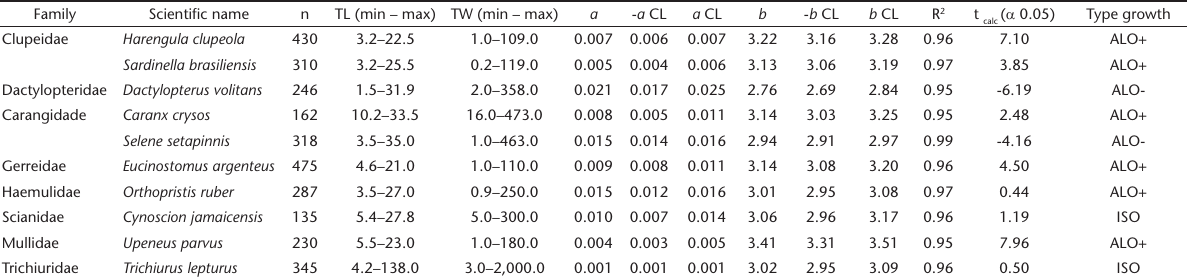
Table 1. Sample size (n), ranges of total length (LT) and weight (TW) of fish species. Values and confidence limits (CL) of a and b , coeffi- cients of determination (R 2 ) and type of growth (ALO+, positive allometric; ALO-, negative allometric and ISO, isometric).